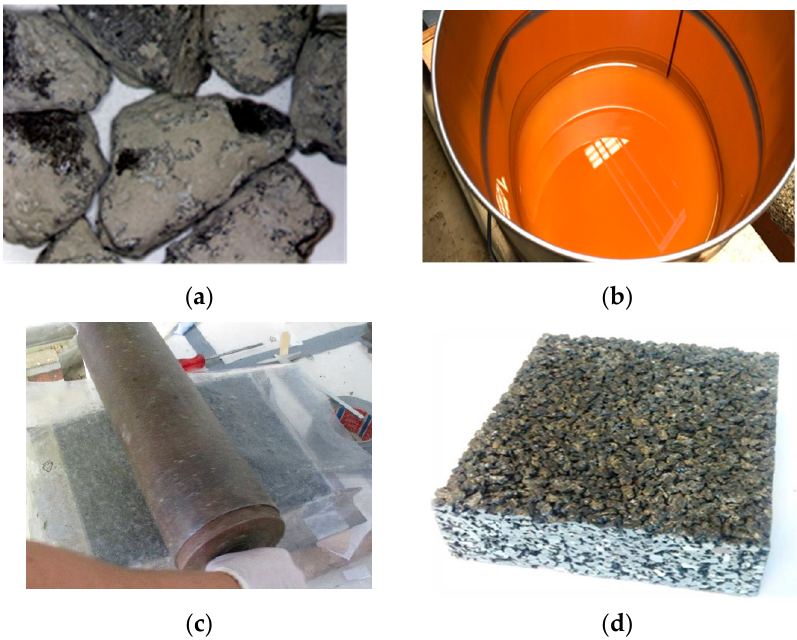
Figure 1. Raw materials for polyurethane (PU) specimens: ( a ) TiO 2 -coated aggregate; ( b ) Bio-based polyurethane binder; ( c ) Compaction process; ( d ) PU specimen.